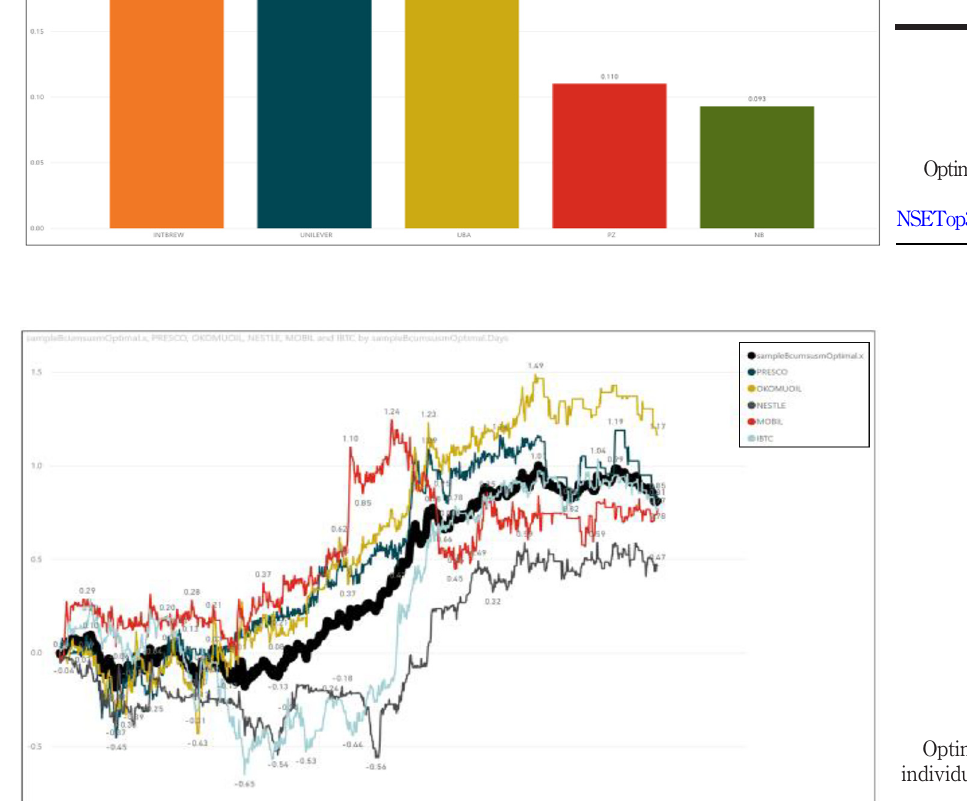
Figure 6. Optimal returns vs individual returns for Sample